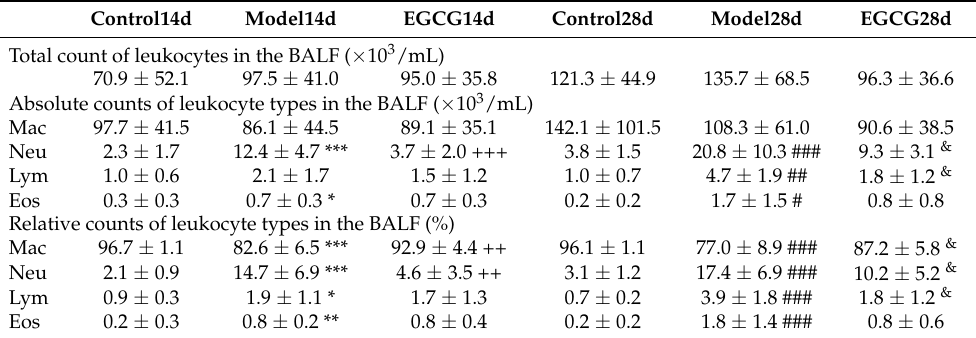
Table 2. Counts of leukocytes in the BALF of saline-instilled animals (Control), silica-instilled non- treated animals (Model), and EGCG-treated silica-instilled animals (EGCG) after 14 days (14d) or 28 days (28d) of the treatment delivery. Control14d Model14d EGCG14d Control28d Model28d EGCG28d Total count of leukocytes in the BALF ( × 10 3 /mL) 70.9 ± 52.1 97.5 ± 41.0 95.0 ± 35.8 Absolute counts of leukocyte types in the BALF ( × 10 3 /mL) Mac 97.7 ± 41.5 86.1 ± 44.5